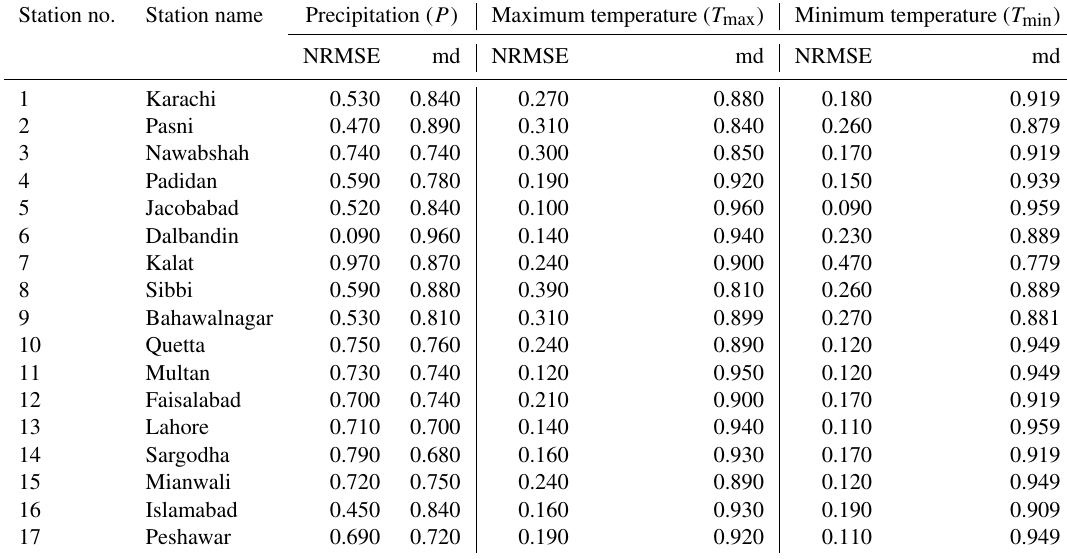
Table 2. Validation of accuracy of GPCC P and CRU T max and T min using NRMSE and md. Station